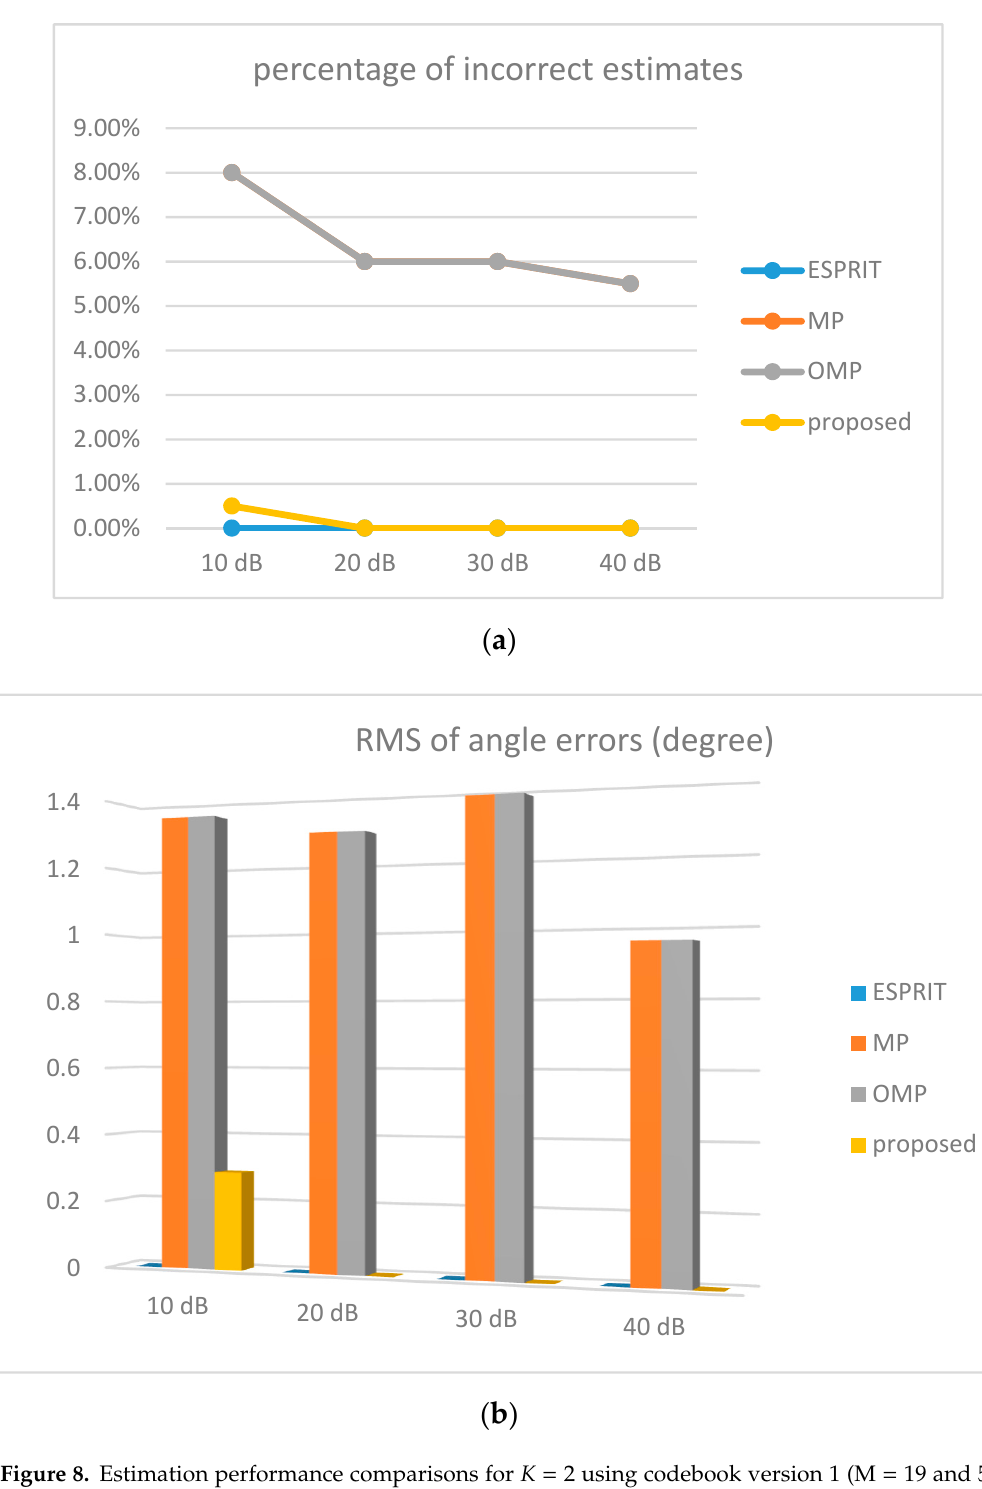
Figure 8. Estimation performance comparisons for K = 2 using codebook version 1 (M = 19 and 5° angular resolution). ( a ) Percentage of incorrect estimates; ( b ) RMS of angle estimation errors.